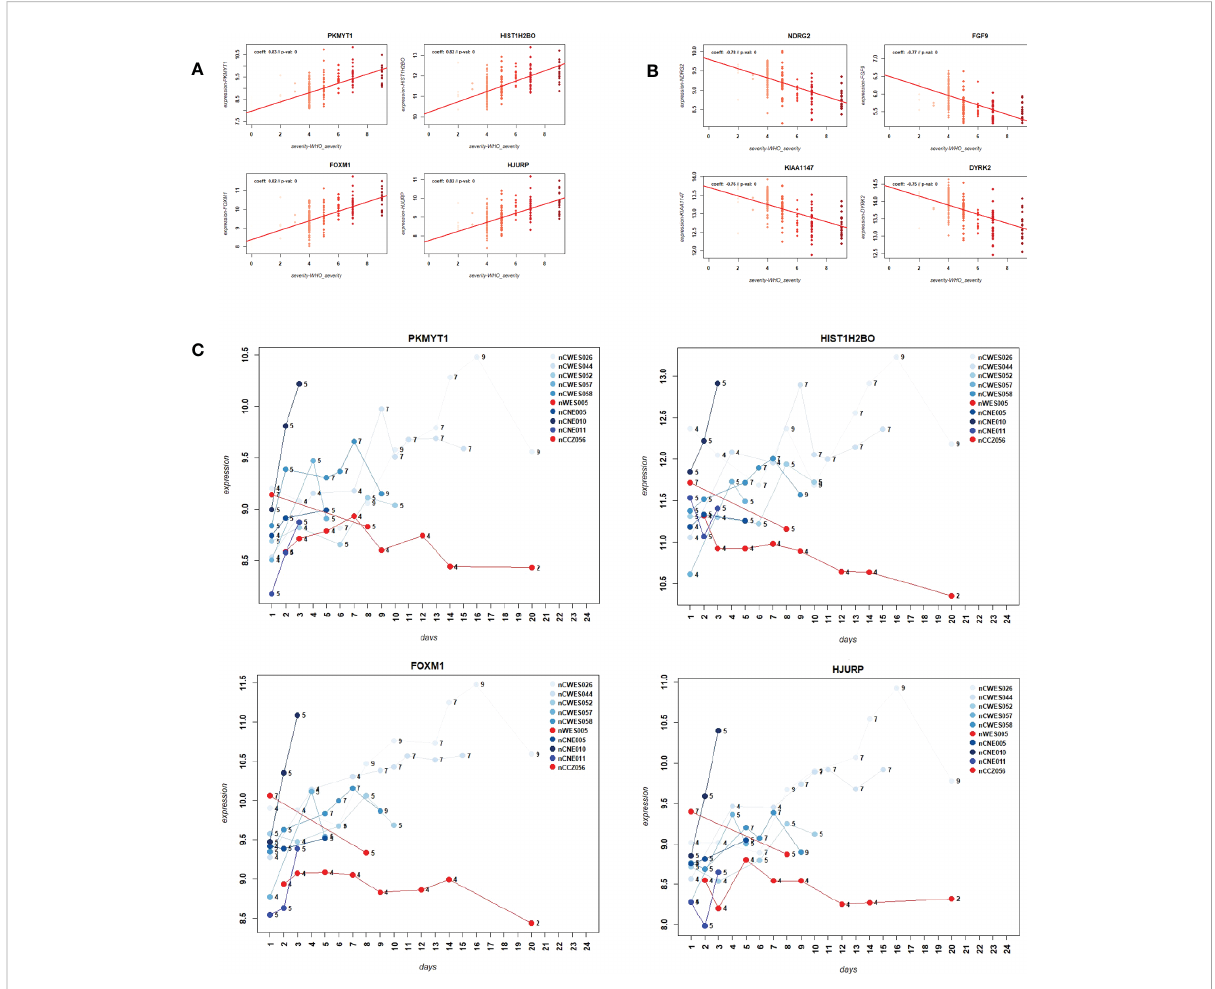
FIGURE 3 Correlation of gene expression levels with WHO severity levels. (A) Scatter plot for the four most strongly positively correlated DEGs with WHO severity levels. Y-axis: gene expression levels for indicated genes, X-axis: WHO severity levels 0 to 9. (B) Scatter plot for four most strongly negatively correlated DEGs with severity levels. Y-axis: gene expression levels for indicated genes, X-axis: WHO severity levels 0 to 9. (C) Expression levels over time for ten paarticipants for correlated genes PKMYT1, HIST1H2BO, FOXM1 and HJURP . Y-axis: gene expression levels for indicated genes, X-axis: day of sample collection after hospital admission of individual patient. Numbers on the line graphs stand for WHO severity levels at the time of sample collection. Note that not all participants were sampled at all the time